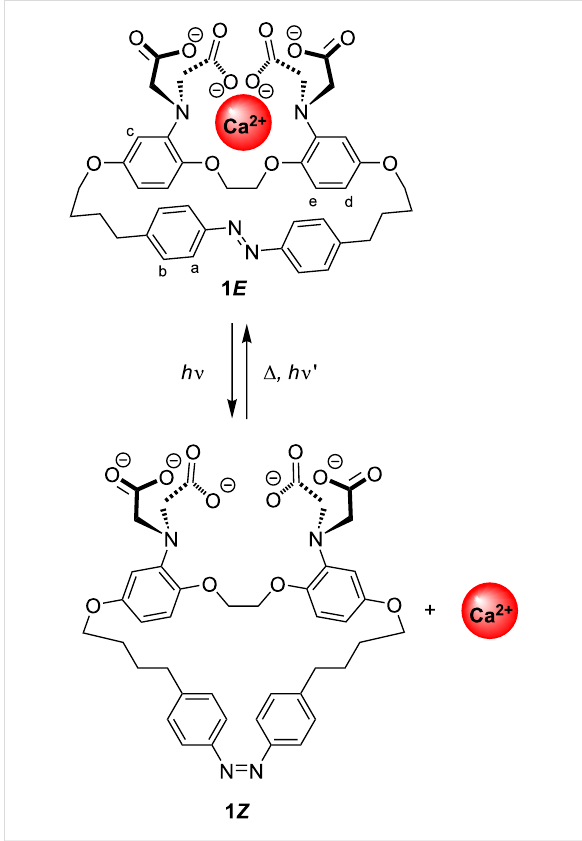
Figure 1: Azobenzene-BAPTA 1 E and 1 Z (a, b, c, d and e denote spe- cific protons), showing idealized Ca 2+ uptake and release. Counter ions omitted for